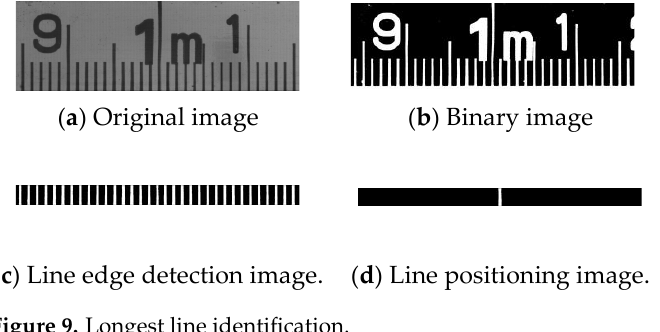
Figure 9. Longest line identification.